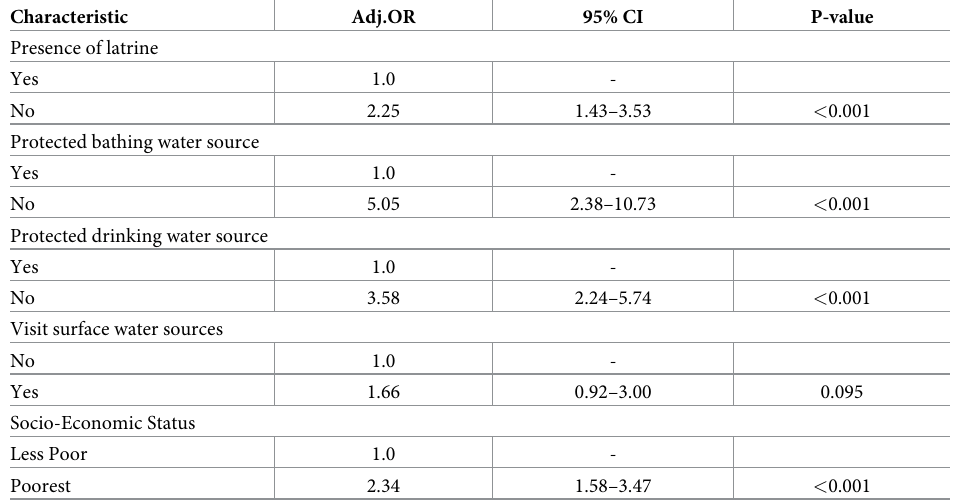
Table 6. Multivariate analysis of the relation between PHS villages and other indicators in the adult population. Characteristic